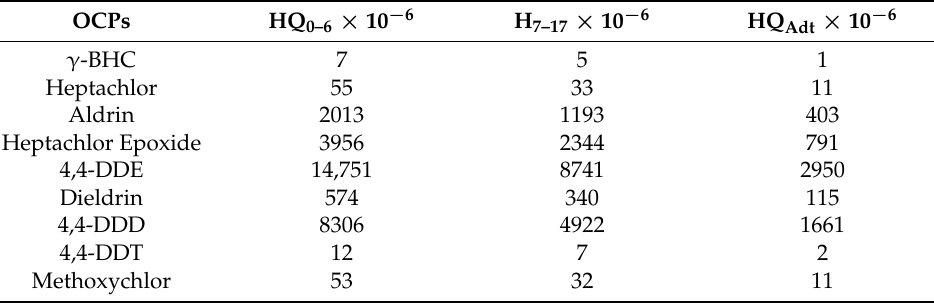
Table 5. Hazard Quotient (HQ) of OCPs for age 0–6, 7–17 years, and adult.